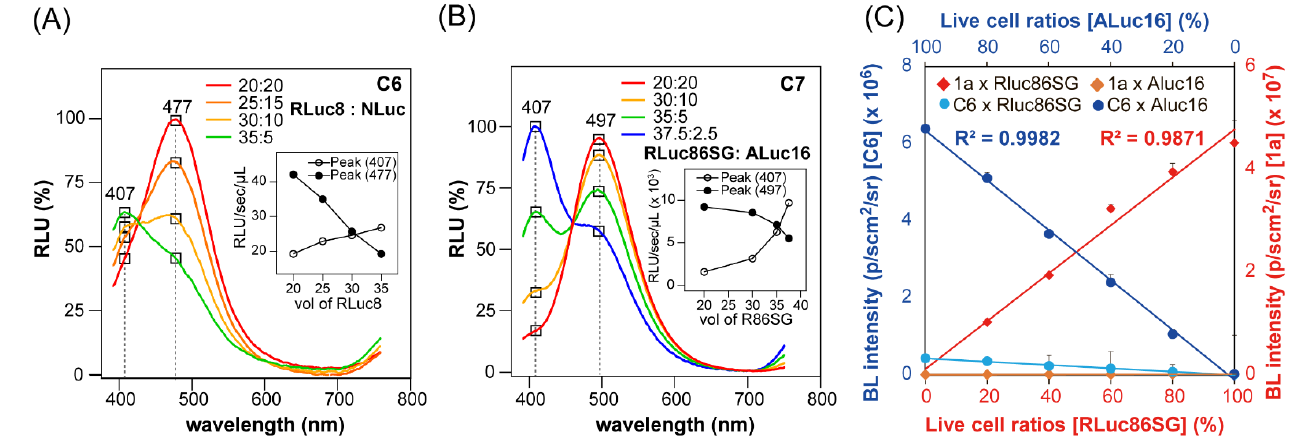
Figure 4. ( A ) Multi-reporter BL spectra of rational mixtures of ALuc16 and RLuc8.6SG in live COS-7 cells in the presence of C6 . The legends denote the volume ratios of the mixtures. ( B ) Multi-reporter BL spectra of rational mixtures of ALuc16 and RLuc8.6SG in live COS-7 cells in the presence of C7 . The peaks at 412 nm and 496 nm are the signatures of RLuc8.6SG and ALuc16, respectively. The legends denote the volume ratios of the mixtures. C7 was chosen because it is luminescent with both ALuc16 and RLuc8.6SG, and thus is suitable for multi-reporter imaging. ( C ) Quantitative profile of the BL intensities of different ratios of live cells of ALuc16 and RLuc86SG totaling 100%. The BL intensities were developed with the substrate solutions of 1a and C6 . The substrates 1a and C6 were chosen because they are specifically bright with RLuc86SG and ALuc16, respectively.